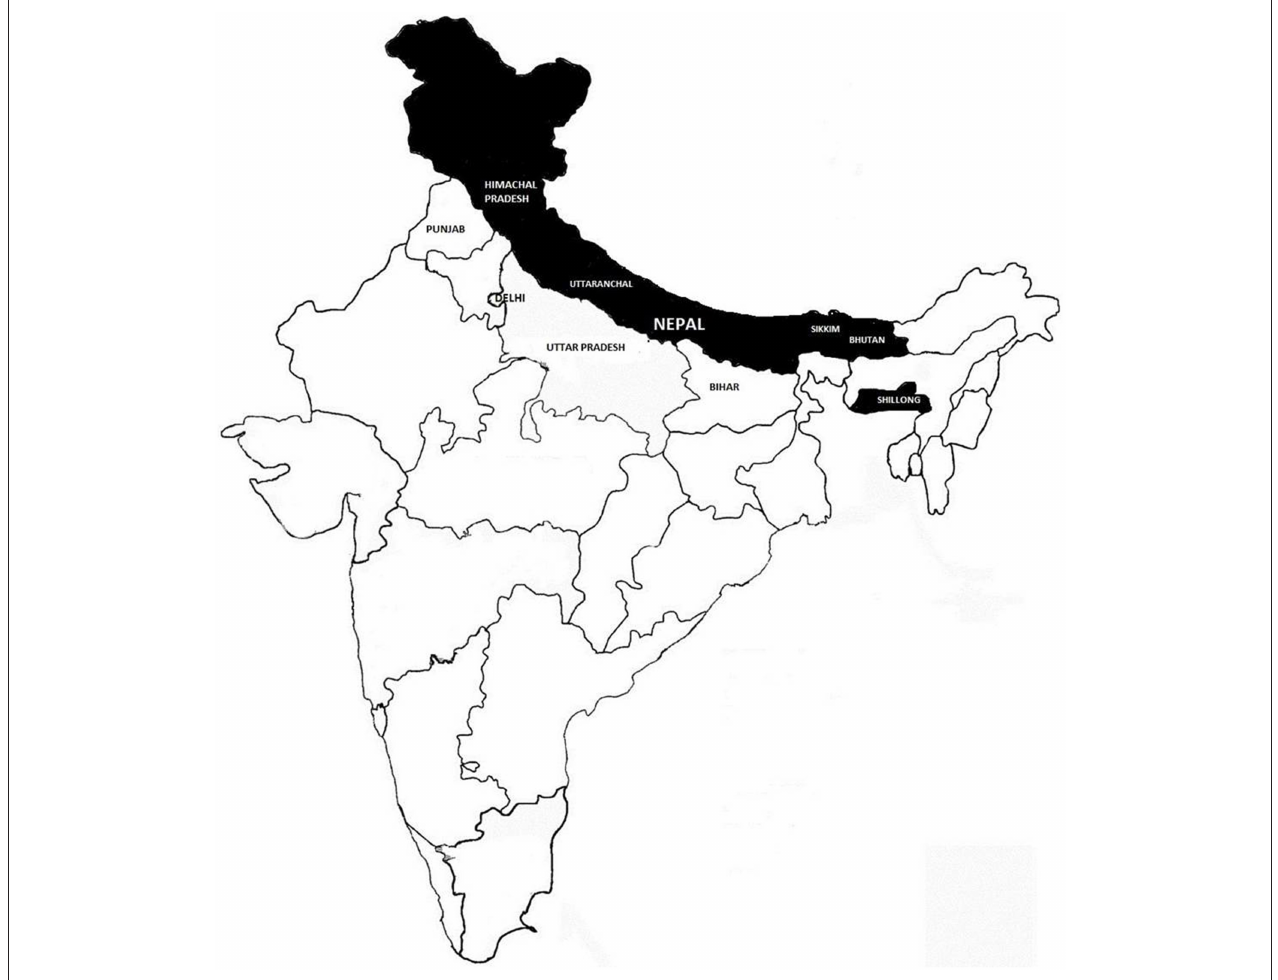
FIGURE 2 | Natural distribution of Swertia chirayita. The shaded area represents the natural habitat of Swertia chirayita in the Himalayan Region.